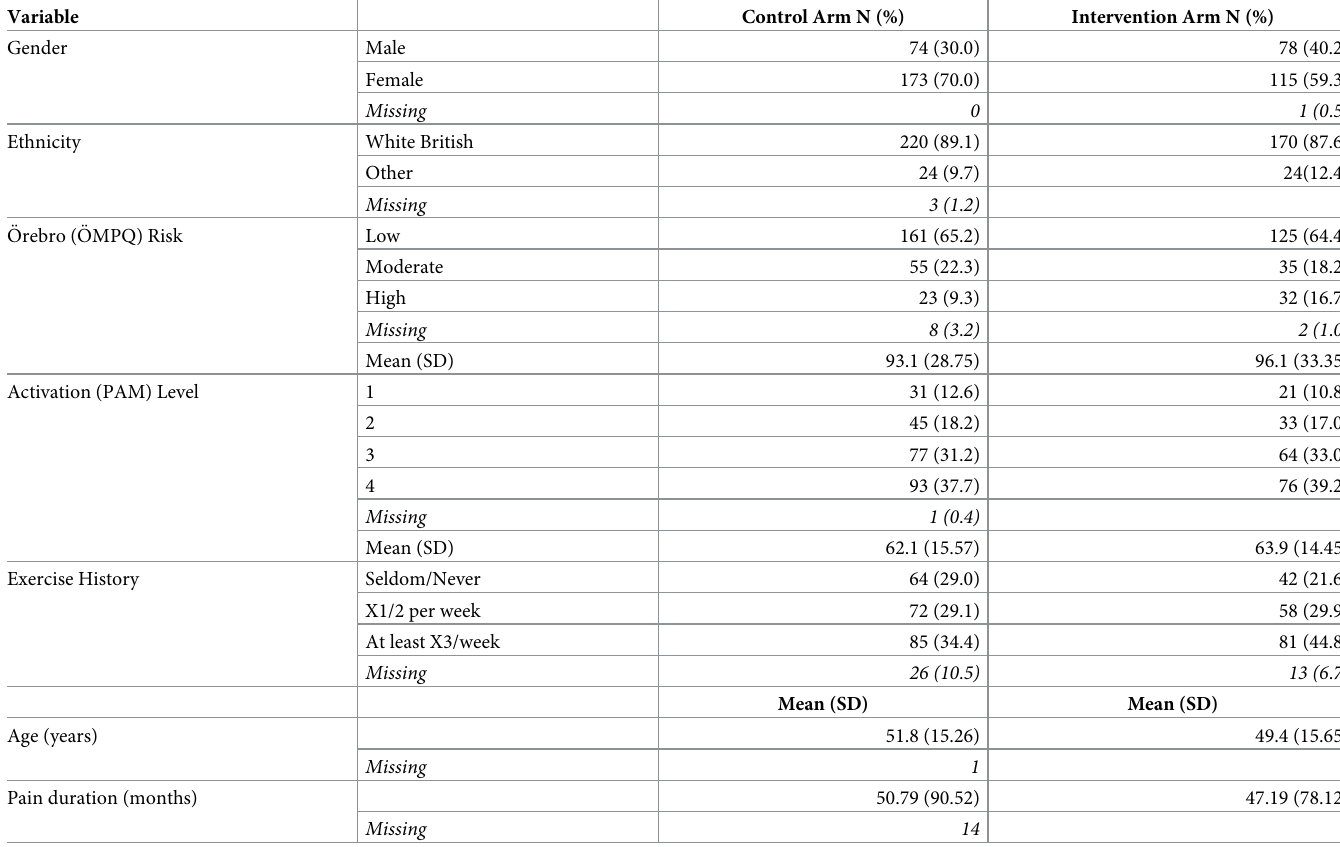
Table 3. Baseline characteristics of exposed and unexposed patients (N =